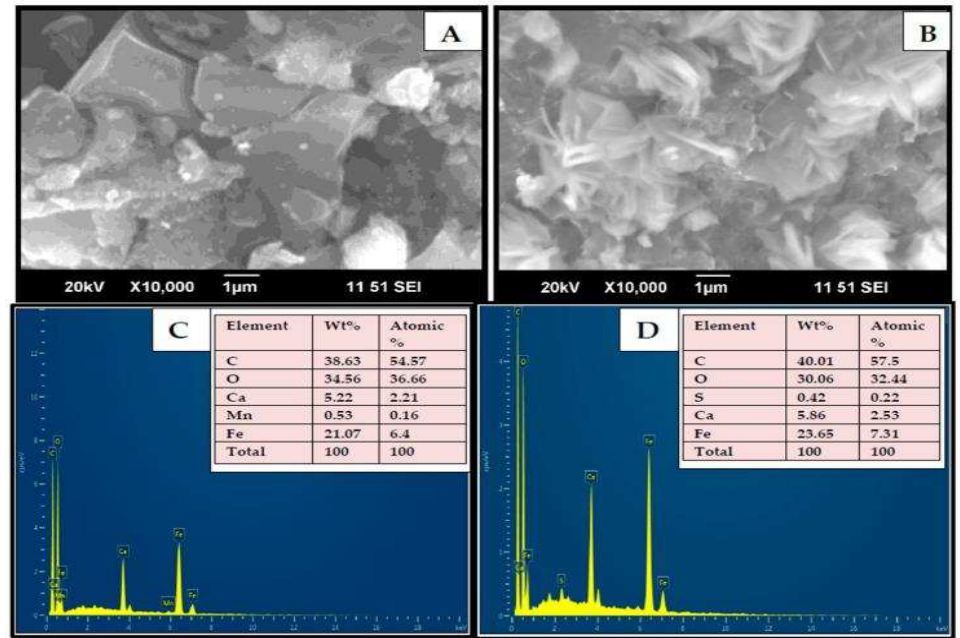
Figure 5. SEM-Energy Dispersive X-ray Spectrometry (EDX) images of Fe 3 O 4 /AC/CD/Alg polymer beads before ( A ) and after ( B ) adsorption. Fe 3 O 4 /AC/CD/Alg elemental analysis before ( C ) and after ( D ) adsorption [97].